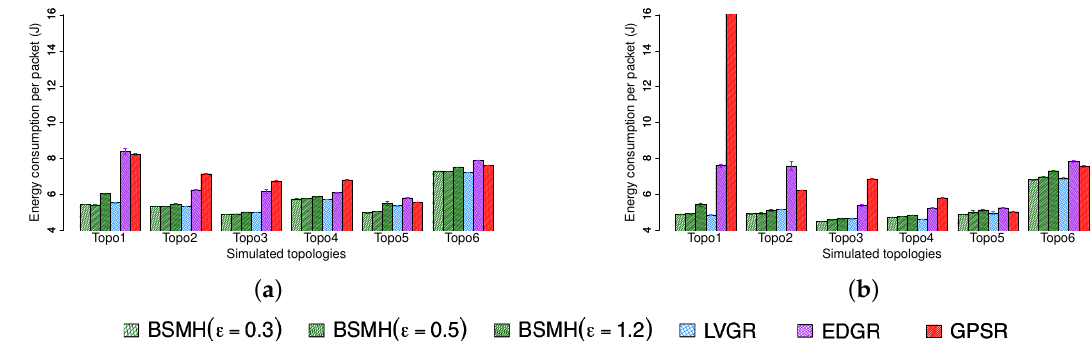
Figure 16. Average energy consumption per packet. ( a ) 1-n communication. ( b ) n-n